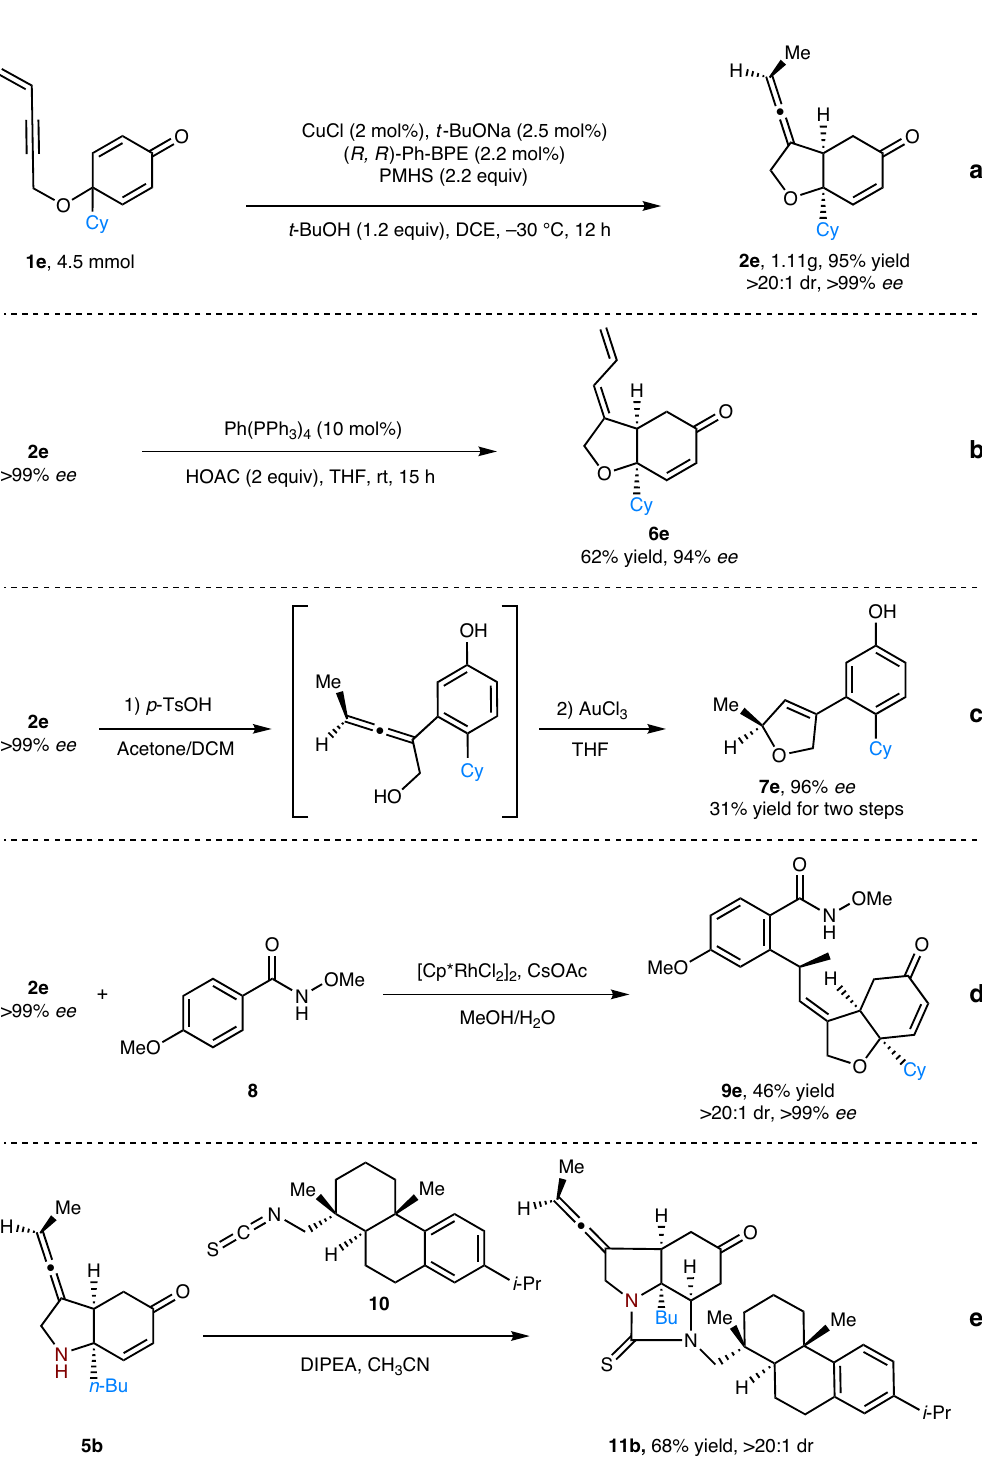
Fig. 4 Synthetic applications. a Gram-scale experiment. b Palladium-catalyzed isomerization of allene. c one-pot synthesis of chiral dihydrofuran. d chirality transfer of allene by rhodium-catalyzed C – H activation. e cyclization of N-linked product 5b